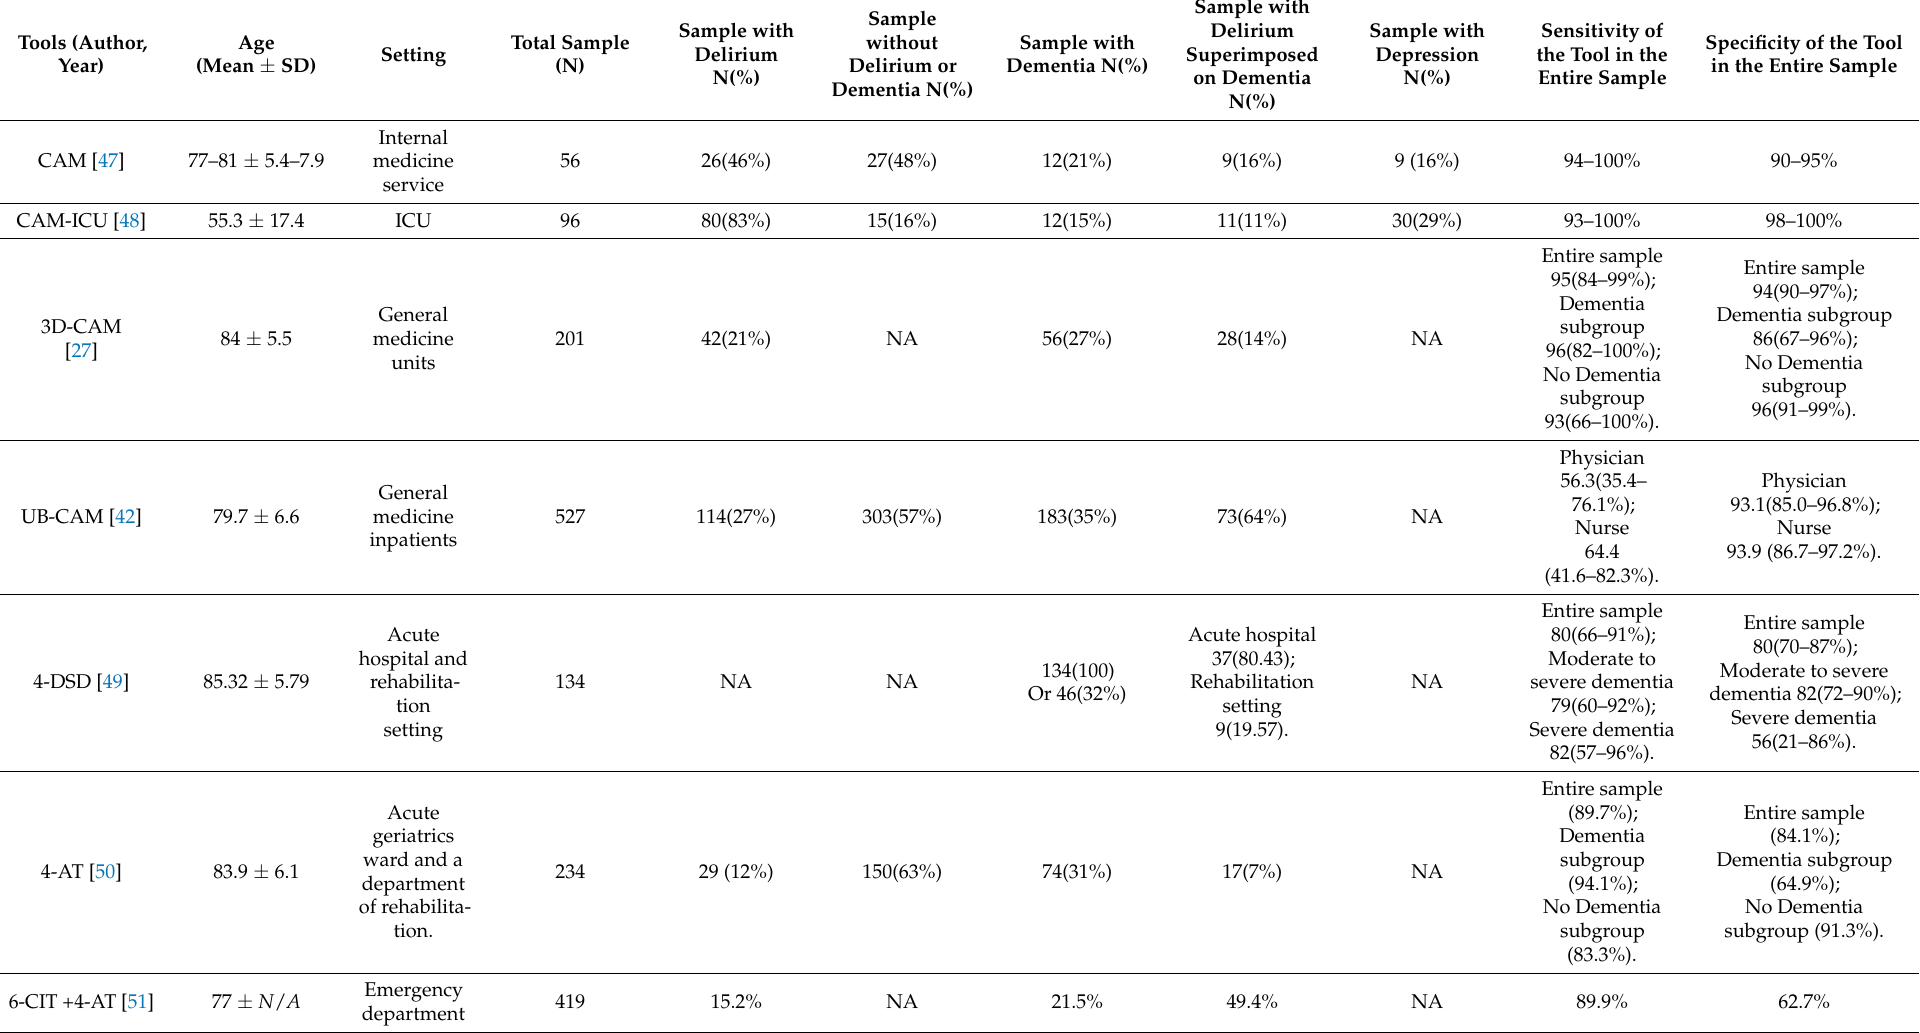
Table 1. Health care professional delirium/delirium superimposed on dementia detection